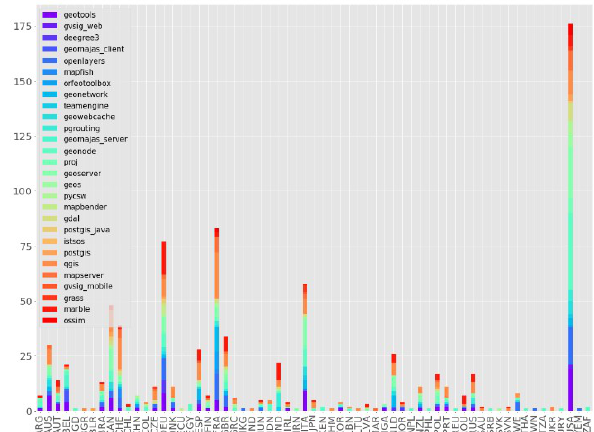
Figure 6. Count of country contributors by project (country code: ISO alpha-3). The Mapguide project does not appear in the legend because none of its contributors was